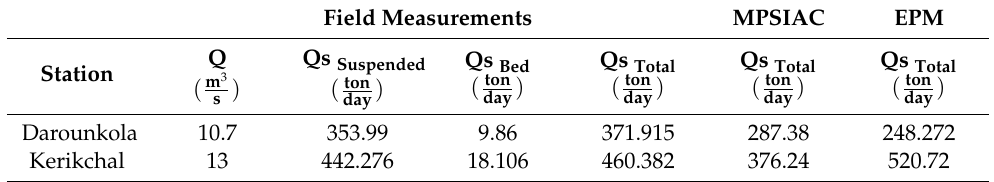
Table 14. Results predicted by MPSIAC and EPM methods compared to the field measurements. Field Measurements